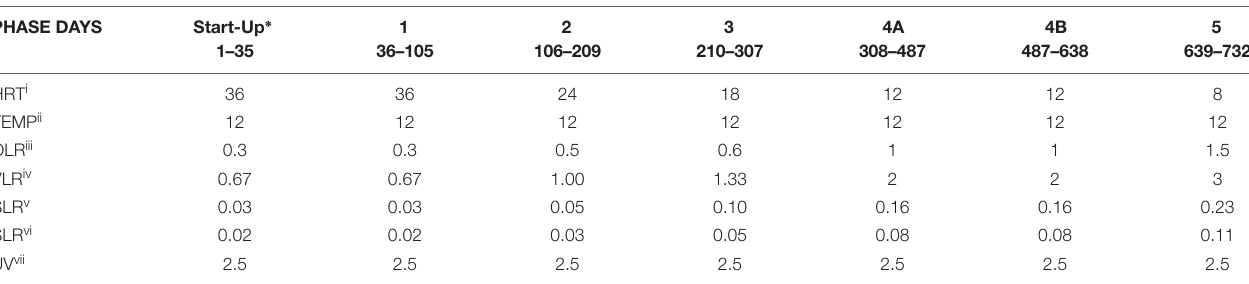
TABLE 2 | Reactor operation phases and associated operational conditions. PHASE